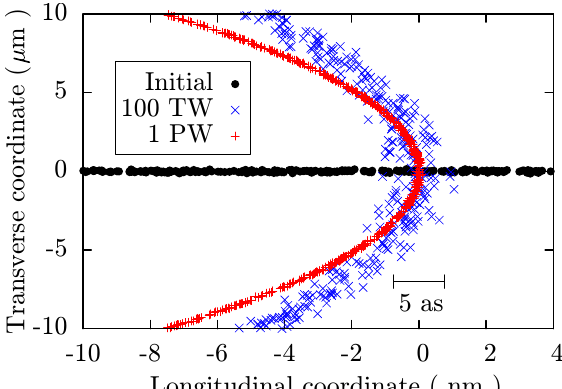
Figure 4. In the sub-cycle regime, a collection of electrons initially at rest at the waist of an ultra-intense 12-fs (FWHM) RPLP ( λ = 800 nm) is bunched to form an attosecond pulse. 0 The initial electron positions ( ) followed a 100-nm spherical Gaussian distribution centered • at ( r, z ) = (0 , 0) . Here, a magnified view reveals the extreme longitudinal compression experienced by the electrons during sub-cycle acceleration. The position of the leading edge of the accelerated electron distributions is about 6 mm away from beam waist. It was translated along z for a direct comparison of the relative durations. The size of the characters used to represent the particles gives the impression that the electron pulses are longer than they really are. For ( + ), we estimate that the duration along the longitudinal axis is as short as 170 zs. Simulation parameters were the following: ( ) P = 100 TW ( k z 280 , 0 0 × (cid:39) was effectively a 2 z 4 . 7 ), ( + ) P = 1 PW ( k 850 , a 2 5 . 1 ). The carrier phase φ 0 0 0 z (cid:39) z (cid:39) (cid:39) optimized for the shortest